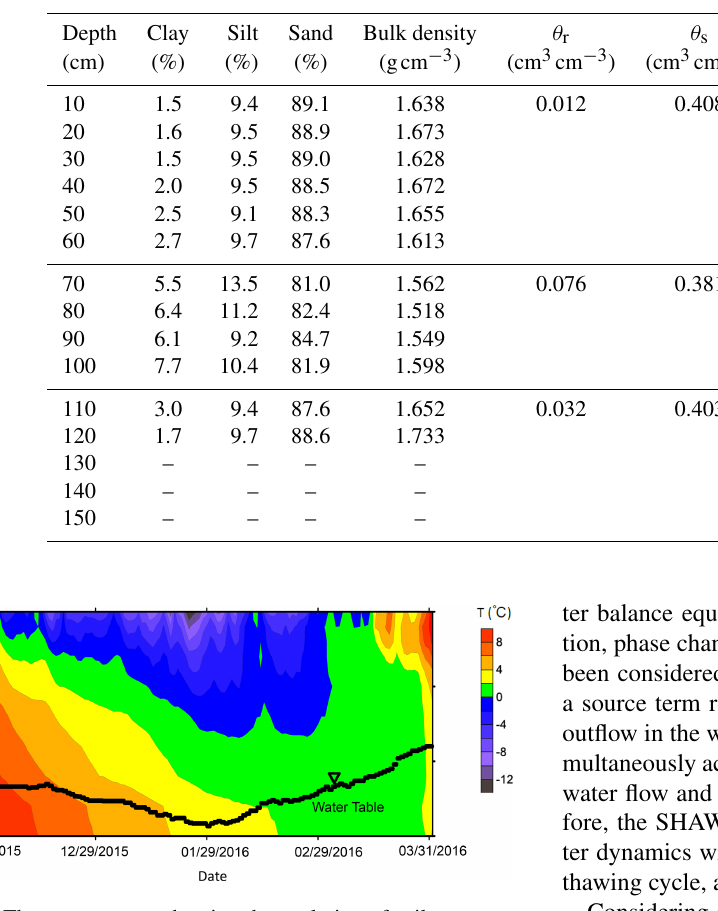
Figure 2. The contour map showing the evolution of soil tempera- ture at the study site during the freezing–thawing cycle. Also shown is the monitored fluctuating groundwater